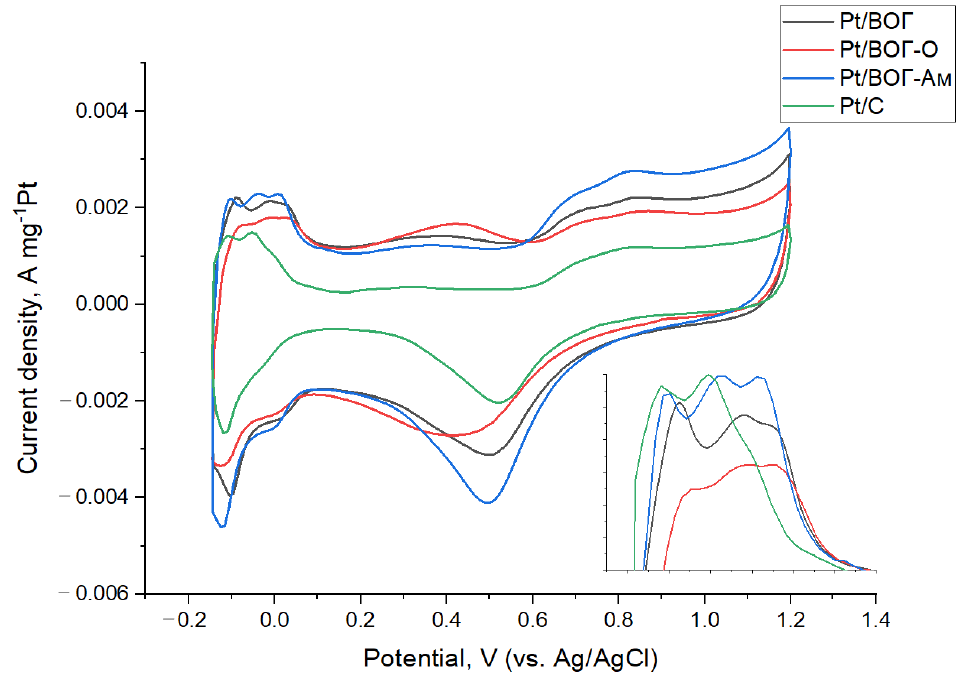
Figure 5. Cyclic voltammograms of Pt 20 /C, Pt 20 /rGO, Pt 20 /rGO-O and Pt 20 /rGO-Am measured in an Ar-purged 0.5 M H 2 SO 4 solution at 20 mV s −1 .